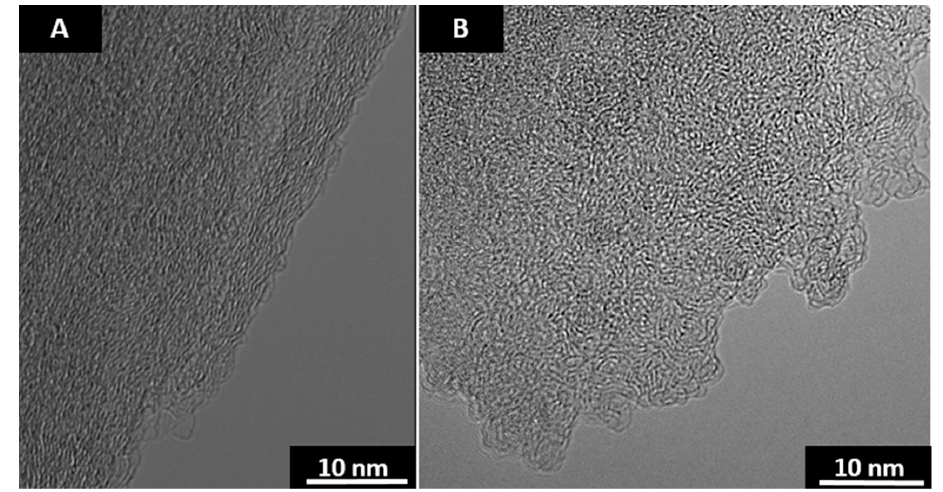
Figure 6. ( A ) TEM micrographs of anthracene coke ( B ) and sucrose char after heat treatment at 1200 °C for 2.5 s.